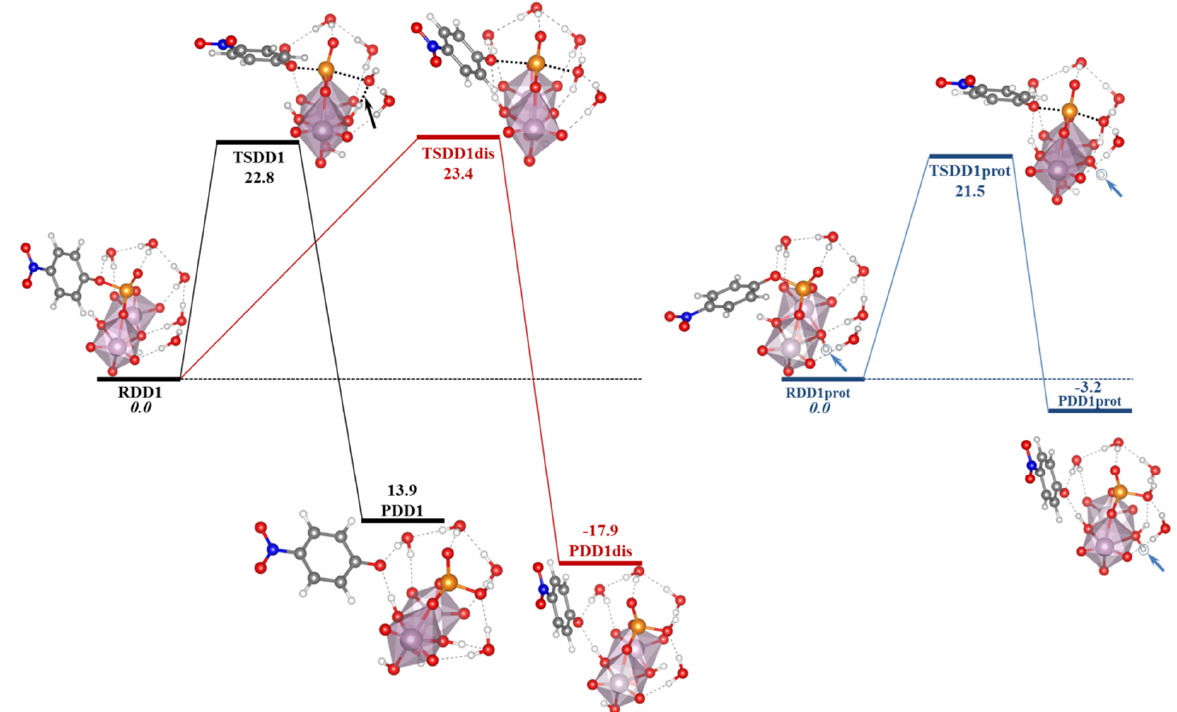
Figure 41. Computed Gibbs free energy profiles for pNPP hydrolysis by considering higher coordination dinuclear molybdenum species at B3LYP/6-311++G(3df,2p)//B3LYP/6-31+G** level by using solvent effects with the PCM approach. The relative Gibbs free energies are in kcal mol − 1 .